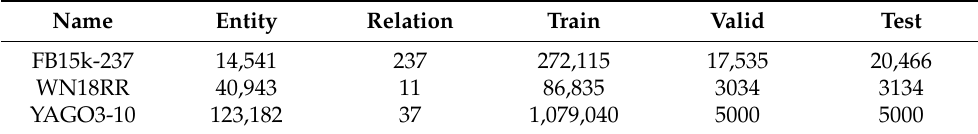
Table 1. Statistical information of datasets in our